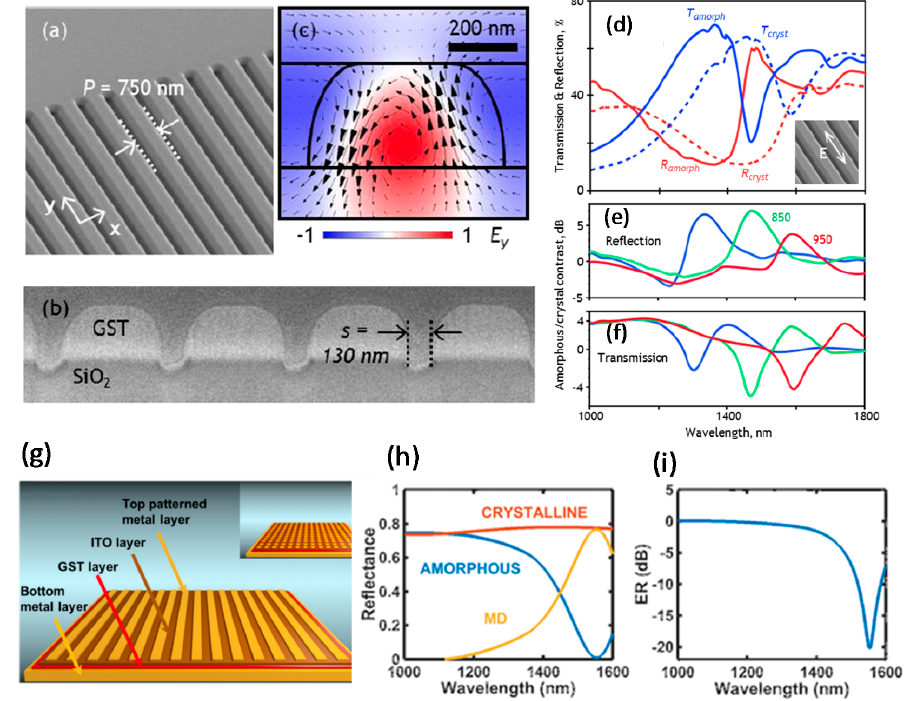
Figure 3. GST-based metasurface with a grating nanostructure. ( a ) Tilted incidence and ( b ) cross-sectional